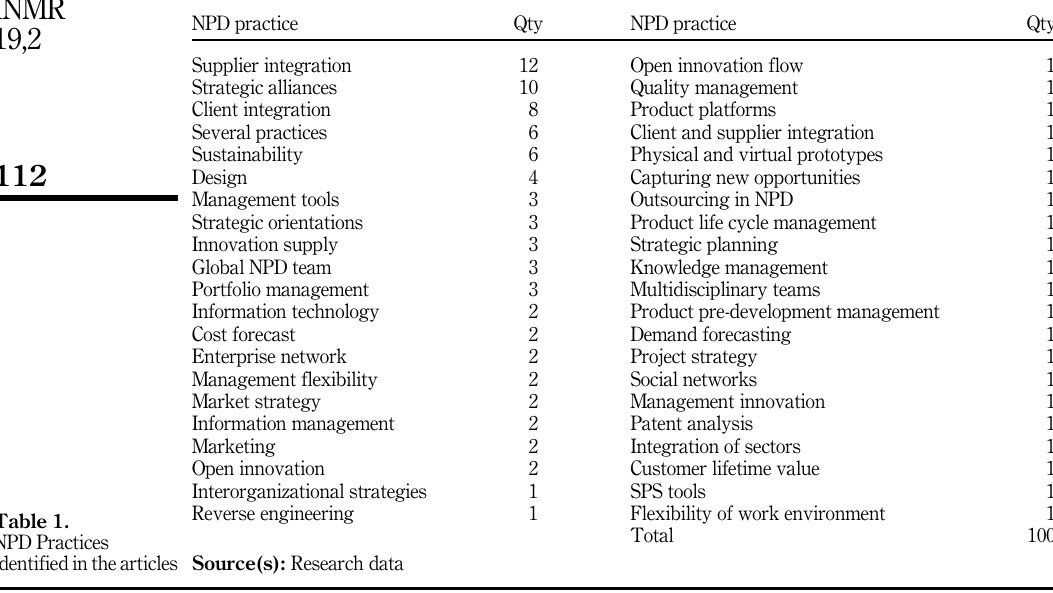
Table 1. NPD Practices identified in the articles